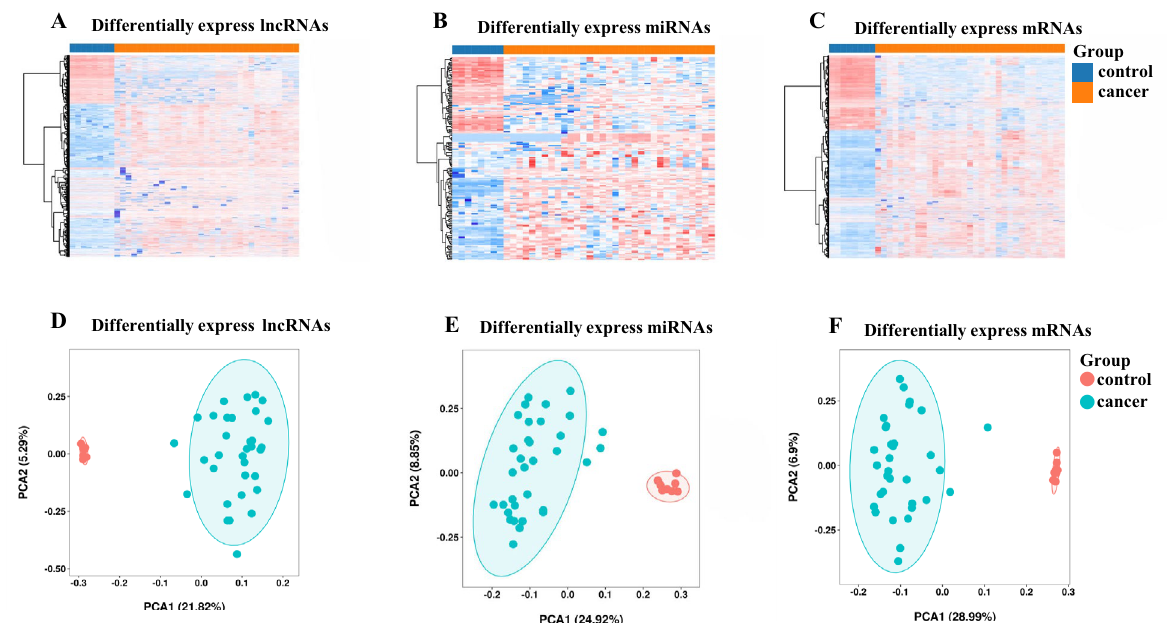
Figure 2. Data from the analysis of differential expression between CCA samples and control samples derived from the TCGA transcriptome. ( A – C ): Heat maps of 2771 DElncRNAs, 173 DEmiRNAs, and 6837 DEmRNAs from 33 CCA samples and 8 normal samples; the upper part of the heat map represents the sample, orange is the control group and blue is the cancer group. ( D – E ): Principal component analysis (PCA) of DElncRNAs, DEmiRNAs, and DEmRNAs. Red is the control group, green is the cancer group, and the circle is the 95% confidence interval. R “ggplot2” package version 3.3–6, < URL: https:// ggplo t2. tidyv erse. org >